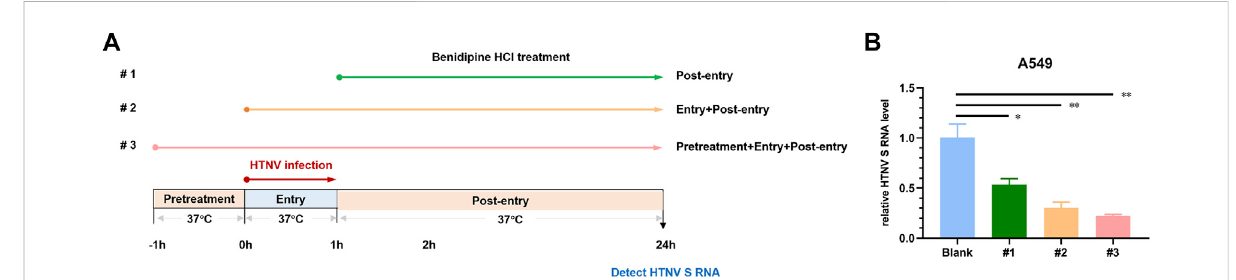
FIGURE 2 In vitro anti-HTNV mechanism of benidipine hydrochloride. (A) Benidipine hydrochloride was administered to Vero E6 cells, as described in the schematic diagram. After HTNV infection, cells were treated with benidipine hydrochloride (#1), or added with HTNV prior to adsorption (#2), or 1 h beforeHTNVandaddedthroughouttheinfectionprocedure(#3). (B) TheeffectofbenidipinehydrochlorideontheentryofHTNV.Asdepictedin (A) , the relative intracellular S segment RNA level of HTNV was determined at 24 h post-infection using a variety of methods. * p < 0.05; ** p < 0.01.